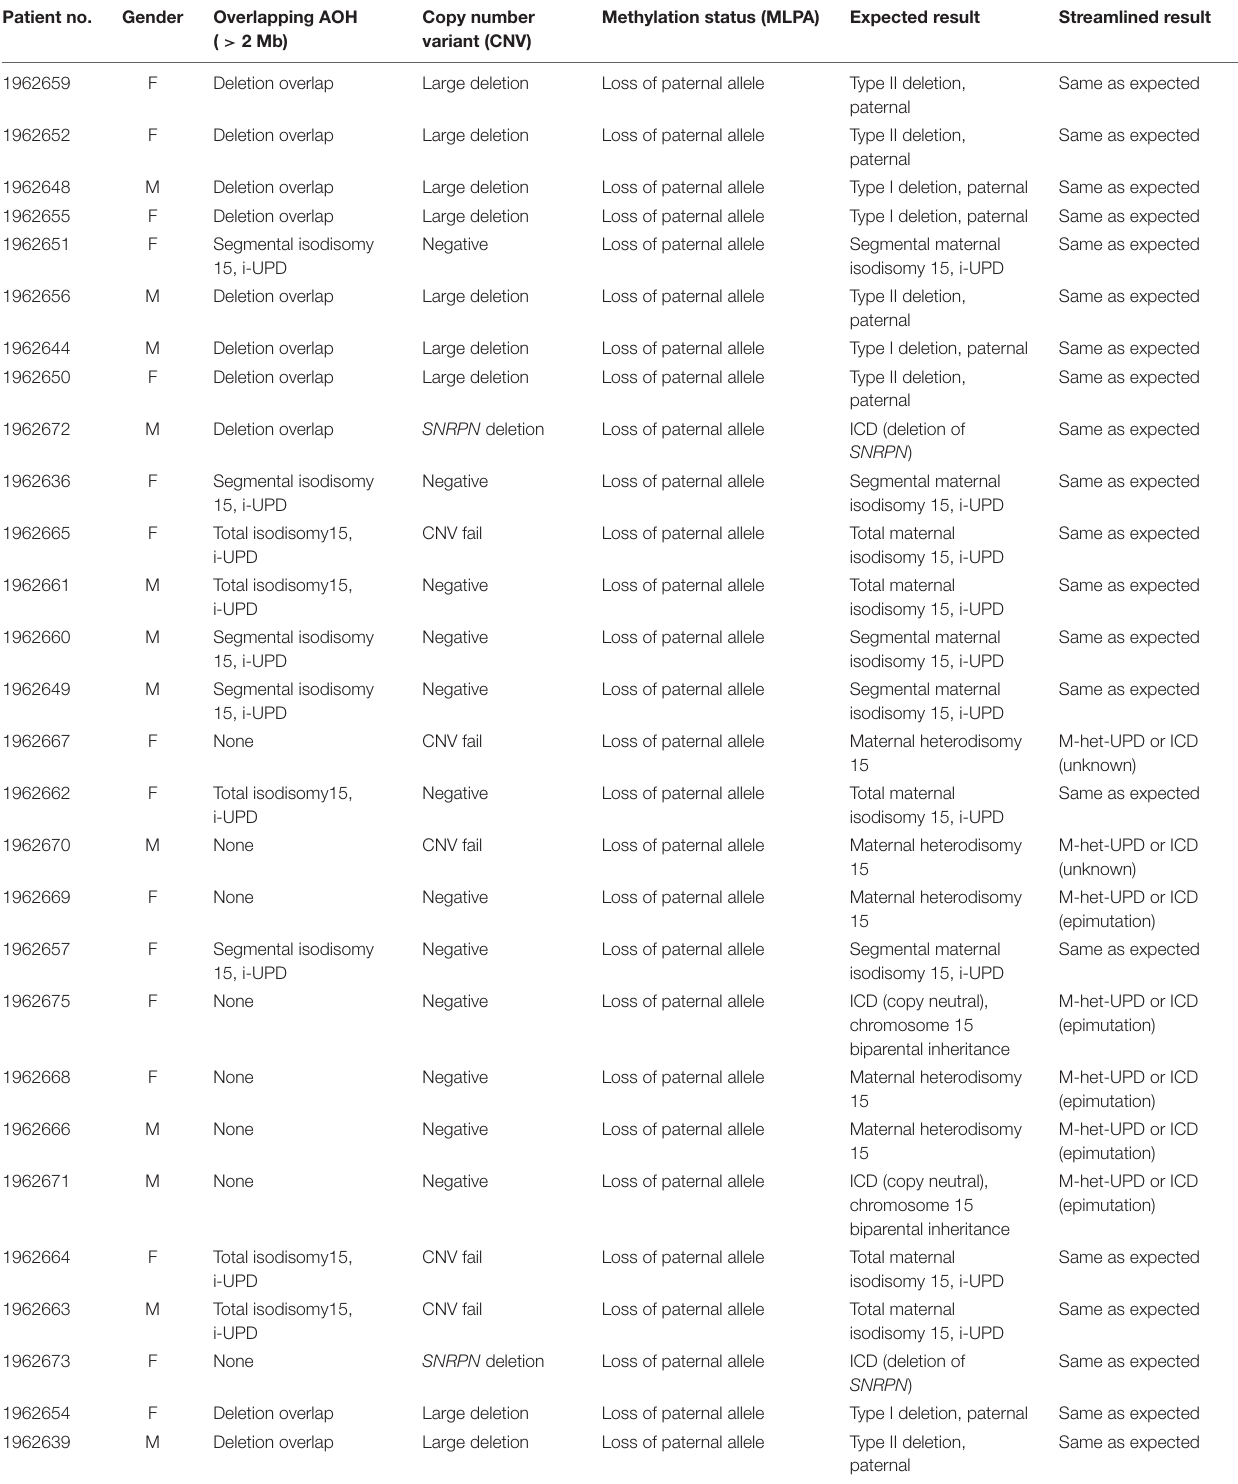
TABLE 1 | Expected and observed results for 28 test patients with Prader–Willi syndrome. Patient